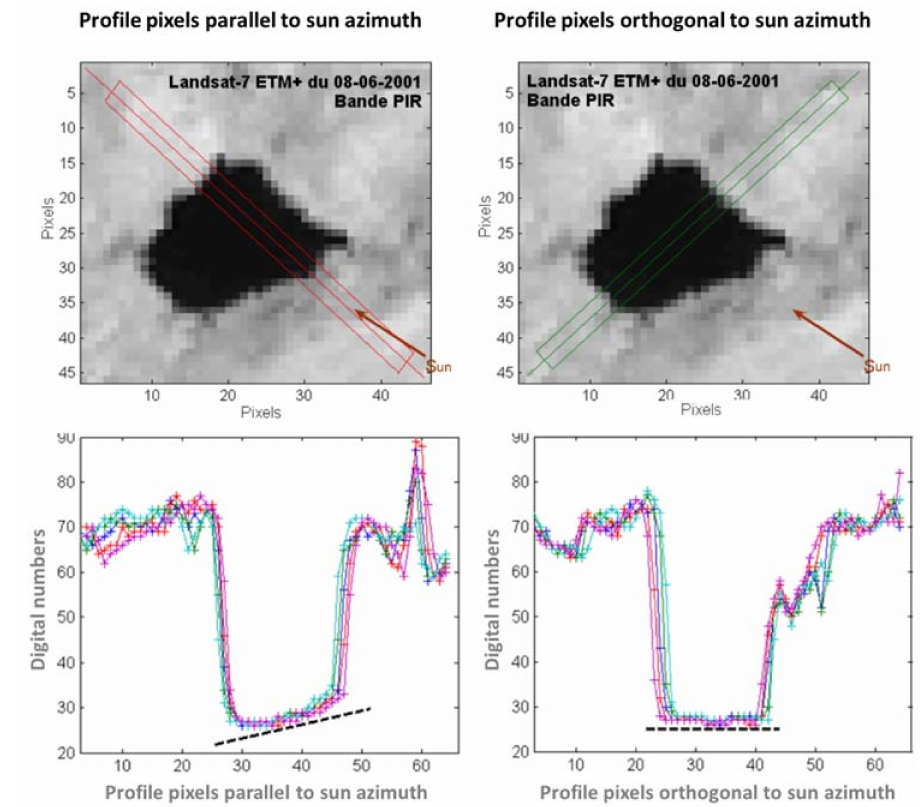
Figure 8. Specular effect of the reflectance of the environment in the NIR band of a Landsat-7 ETM+ image acquired on 8 June 2001 and covering Hertel lake in Mont St-Hilaire, Quebec, Canada. The parameters ( k d , k s ) of Equation (9) can be deduced from these observations. In Figure 8, the apparent reflectances (simplified formula) for the dark pixels 1 and 2 are calculated, considering only the effect of the bright pixels on the dark pixels